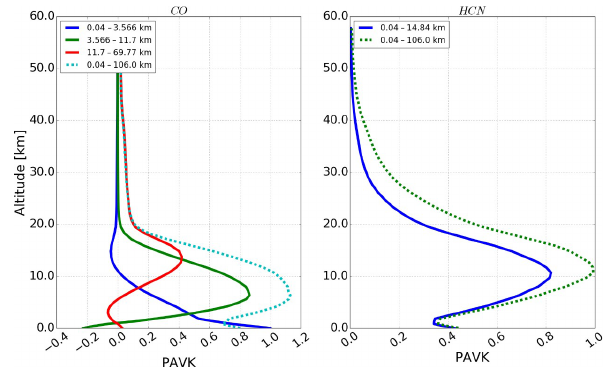
Figure 2. Partial-column averaging kernels (PAVKs) (ppmvppmv − 1 ) for CO and HCN